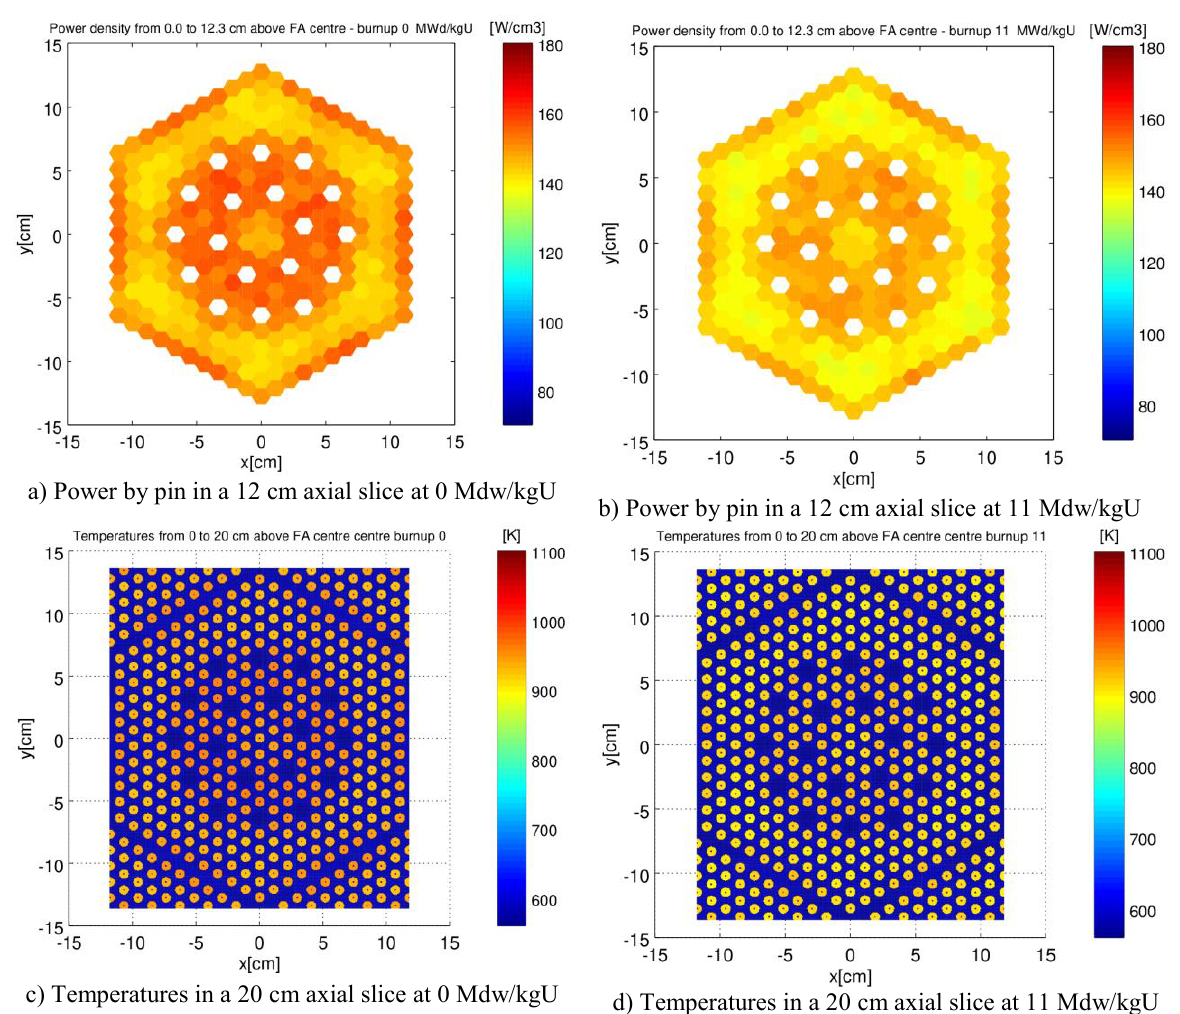
Figure 4 Evolution of power density and temperatures for an axial slice of U-Er FA.